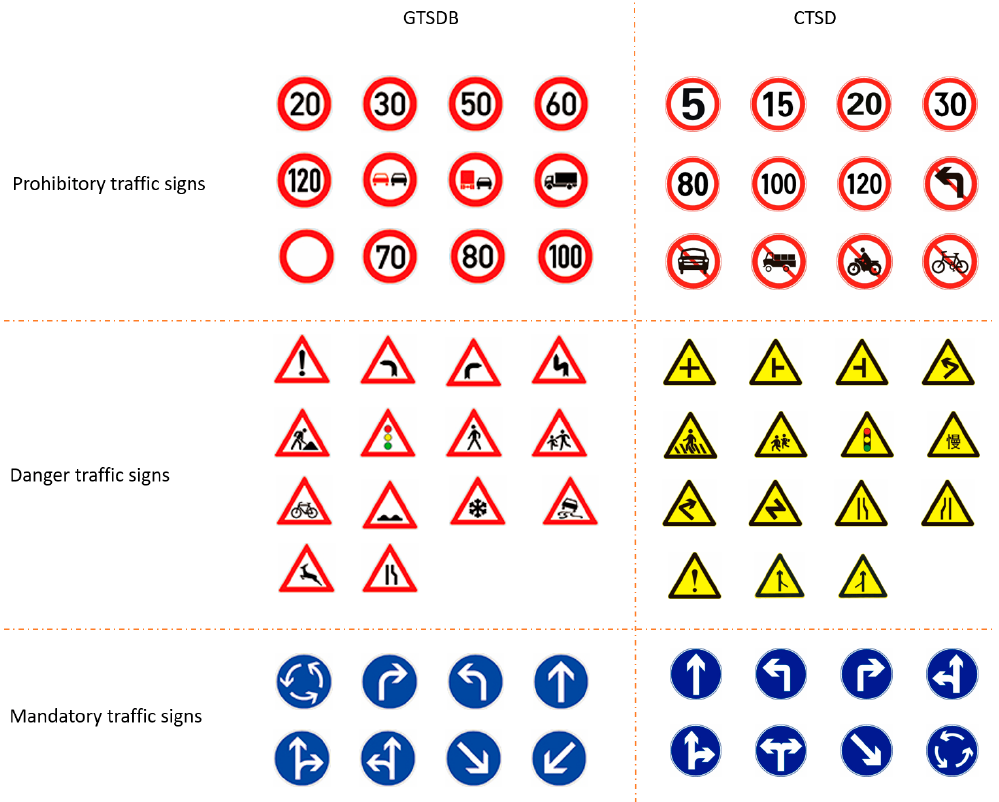
Figure 9. Examples of subclasses in the German traffic sign detection benchmark (GTSDB) dataset and the Chinese traffic sign dataset (CTSD). Merging the Prohibitory, Danger and Mandatory traffic signs from the two databases into super classes, respectively.